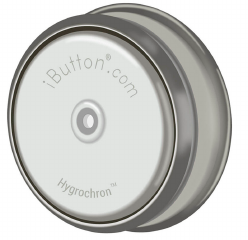
Figure 5. Maxim Integrated iButton DS1923 sensor.